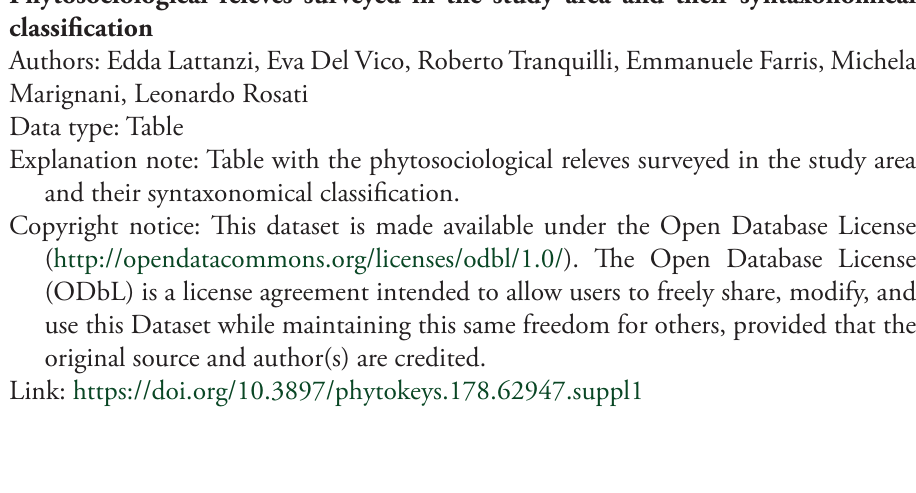
Explanation note: Table with the phytosociological releves surveyed in the study area and their syntaxonomical